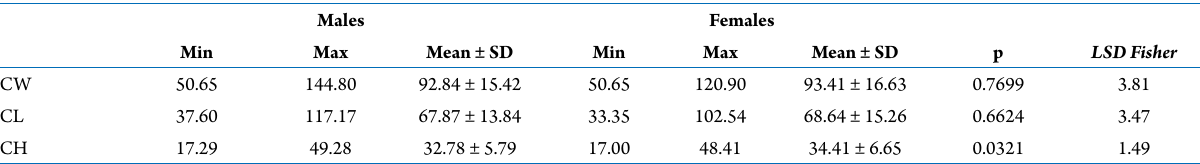
Table 1. Minimum, maximum, mean and standard deviation (SD) size values recorded by sex in Menippe frontalis in the Gulf of Guayaquil. Probability values (p) from the ANOVA to test for differences in size between sexes, and least significative differences of Fisher